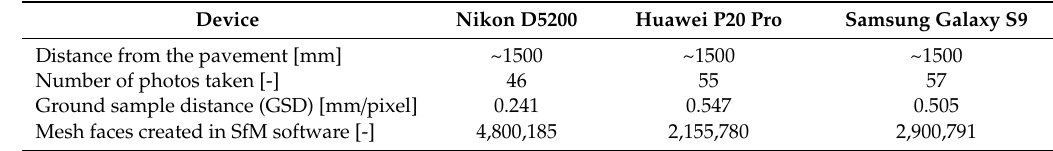
Figure 9. Model produced by imagery from Samsung Galaxy S9. Table 2. Survey specifications for Distress